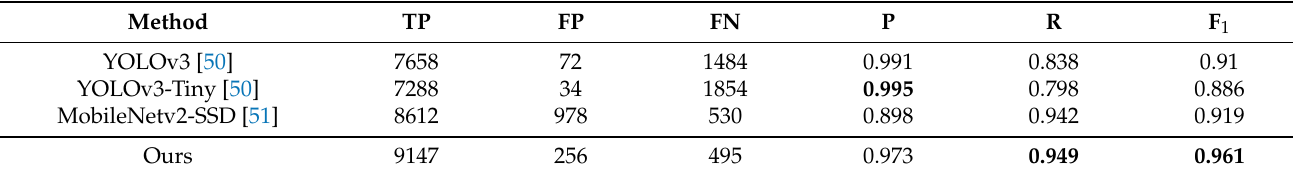
Table 5. Comparison of the CNN-based object detection